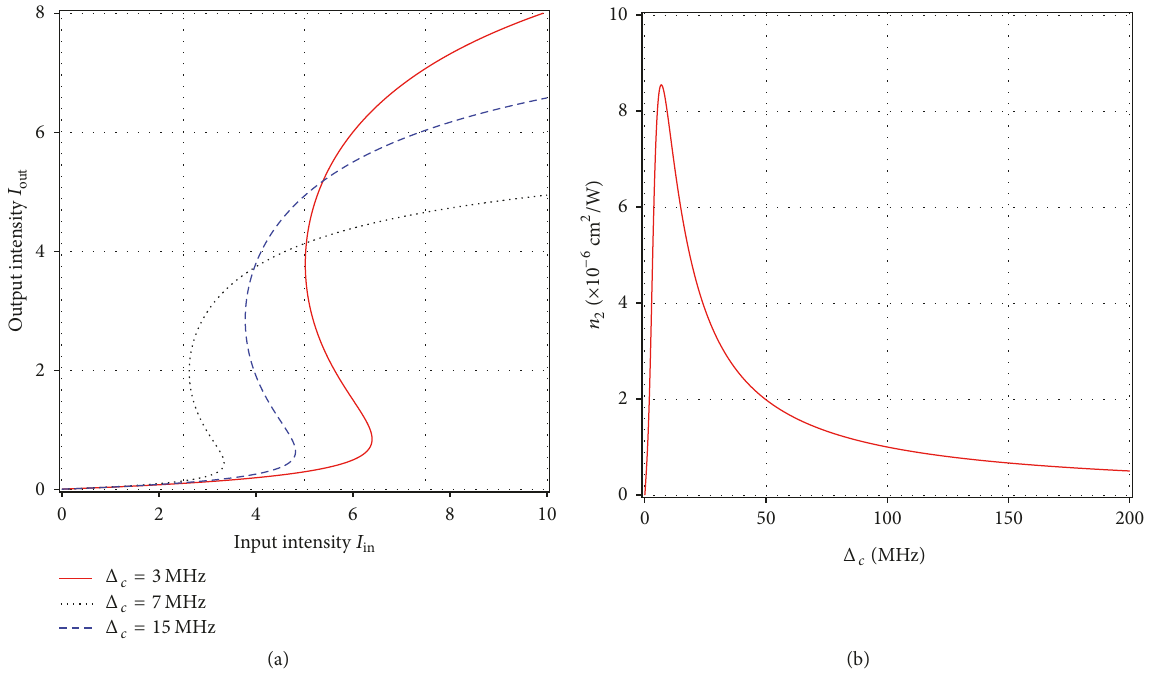
Figure 3: OB curves at particular values of frequency detuning of the coupling field (a) and variation of Kerr coefficient 𝑛 2 versus the coupling detuning (b). The parameters are Ω 𝑐 = 70 MHz, Δ 𝑝 = 0 , and 𝑇 = 300 K.